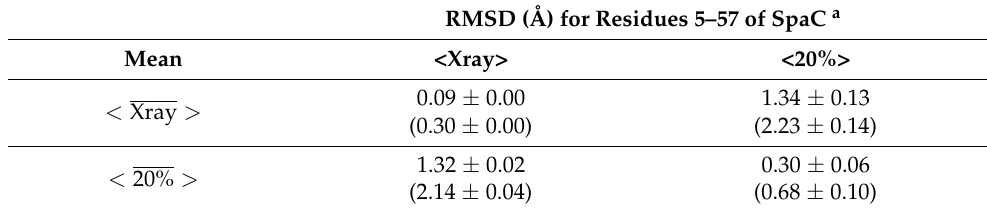
Figure 4. ( A ) Stereoview of the cartoon model of the lowest energy NMR conformer of SpaC determined using the [20% 13 C, 100% 15 N]-labeled sample. ( B ) Stereoview of bundles of the crystal structures (<Xray>, colored in orange) and the 20 NMR conformers determined using the [20% 13 C, 100% 15 N]-labeled sample (<20%>, colored in blue) of SpaC. The C- and N-termini are indicated. ( C ) Stereoview of the superposition of the mean structure of crystal structures (<Xray>, orange) and the mean NMR structure from the [20% 13 C, 100% 15 N]-labeled sample (<20%>, blue) of SpaC. ( D ) The global displacement ( D (glob) ) (Å) among the mean structures of <Xray>, and <20%> for residues 5–57. Backbone heavy atoms (C α , C (cid:48) , N) are indicated with a solid line and heavy atoms (all C, N, O) with a dashed line. The secondary structures are shown above the plots. Table 3. The Comparison of the Crystal and NMR Structures of SpaC (RMSD (Å )).